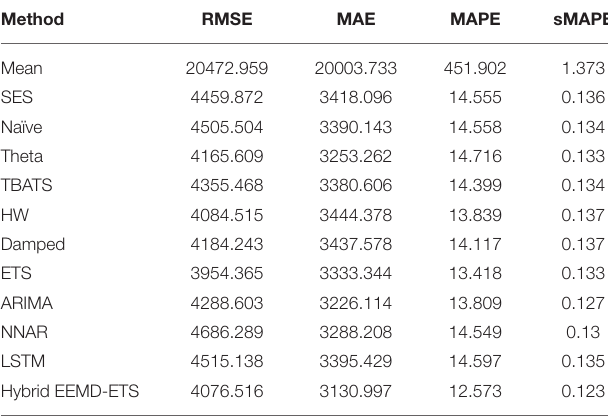
TABLE 11 | Performance comparison of different models for 7 days prediction of UK’s daily cases.